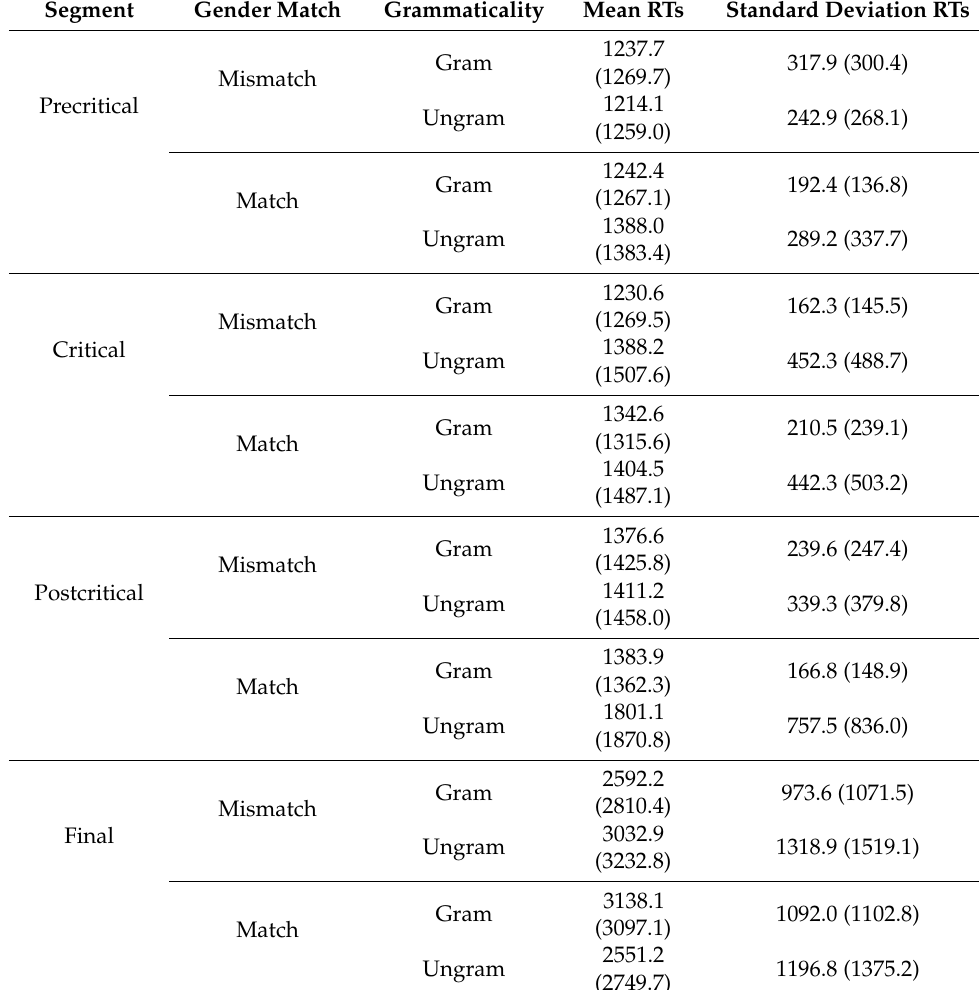
Table A10. Mean raw reaction times and standard deviation for all four sentence types in the precritical, critical, postcritical and final segment for the 2L1 group and in parentheses for the subset of the 2L1 group with MG as dominant language, Match: gender match, Mismatch: gender mismatch, Gram: grammatical, Ungram: ungrammatical, RT: reaction